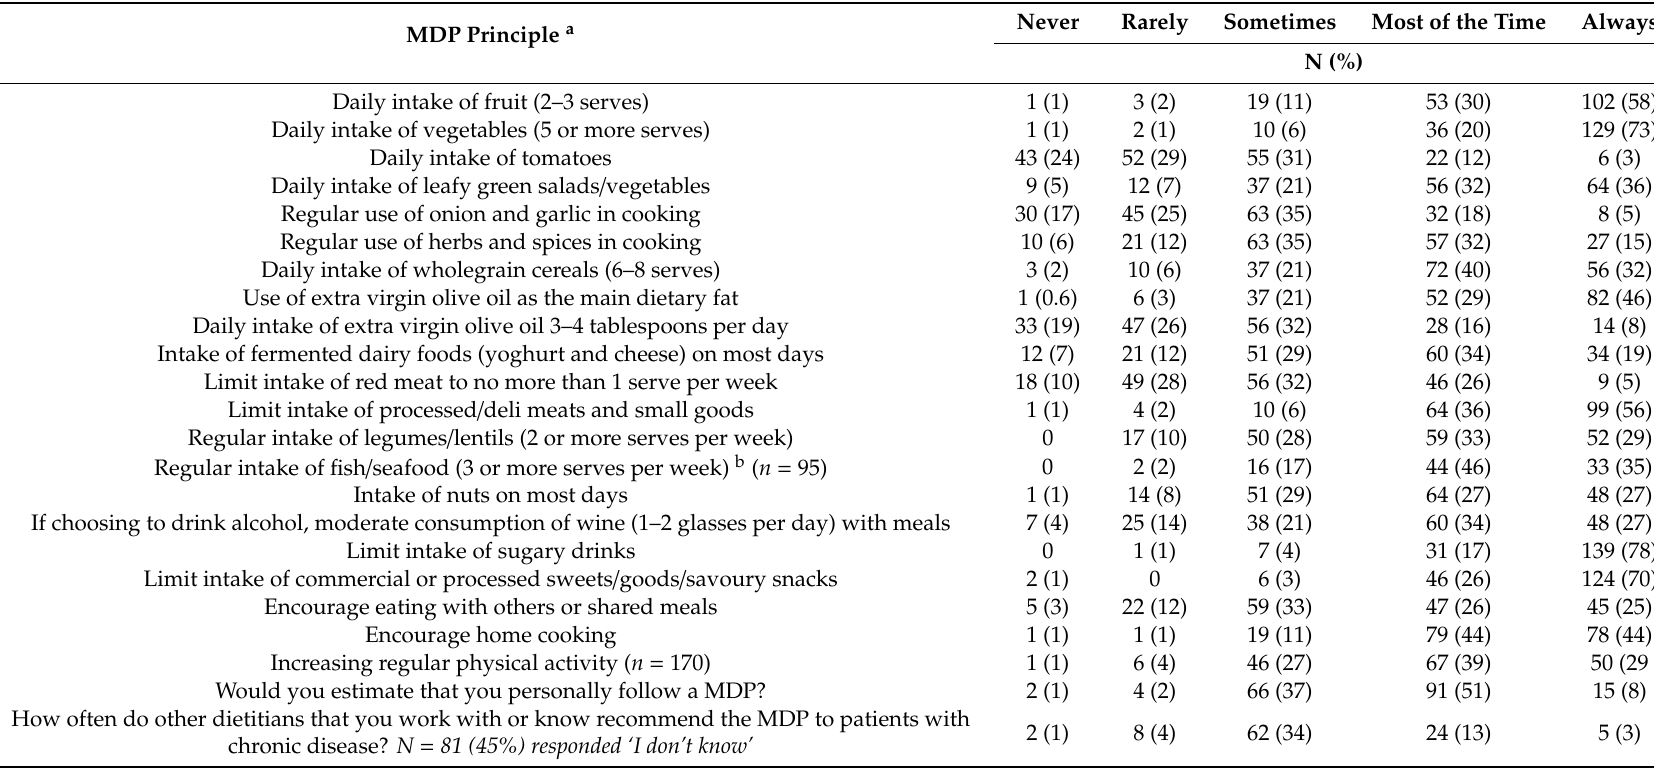
Table 3. Participants’ responses to how often they recommend (in their advice, education or resources) individual principles of the MDP to relevant chronic disease patients ( n =